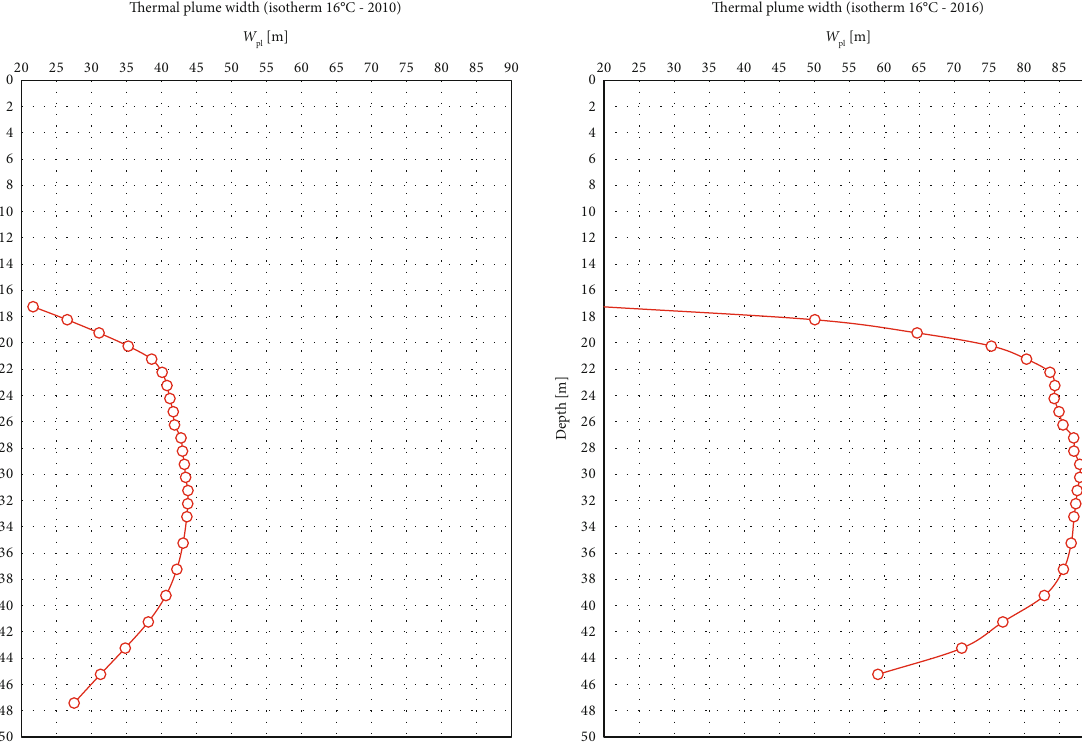
pl ) for each monitored season (2010 and